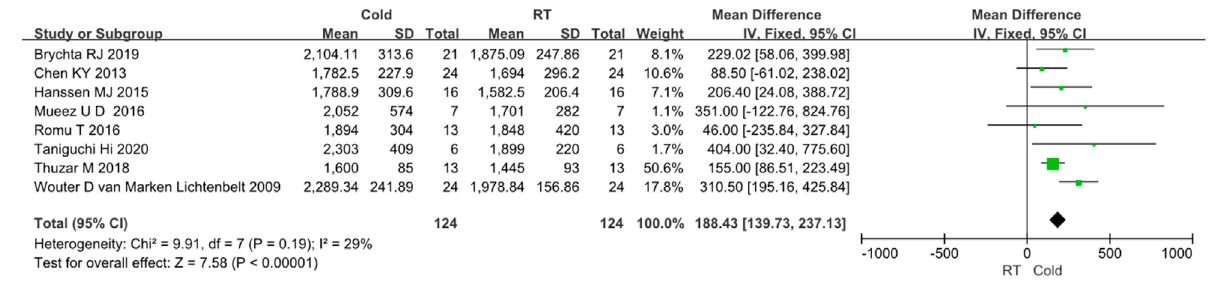
FIGURE 3 | Forest plot for the effect of cold temperature on energy expenditure.